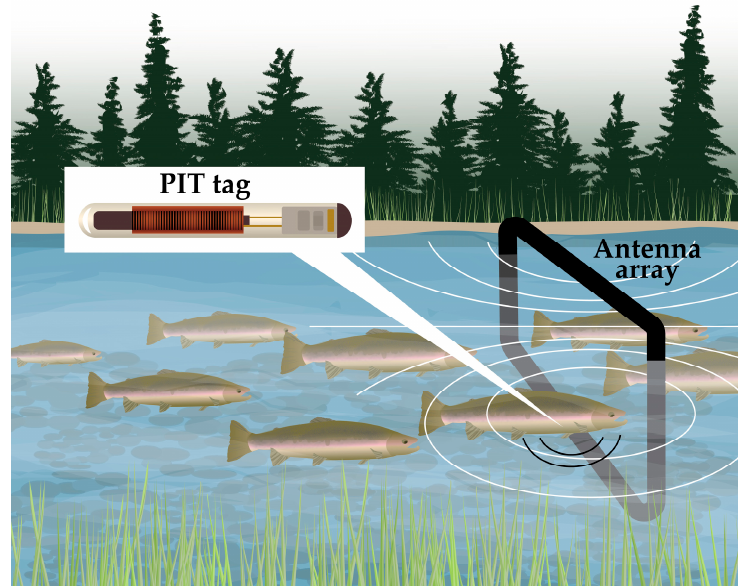
Figure 8. Example of passive integrated telemetry in fisheries management. The antenna array generates an electromagnetic field (white lines). A subcutaneous passive integrated transponder (PIT) tag inside the trout re-emits the array’s signal (black lines) as it passes through the field, providing information on PIT tag number, time, and direction of movement. Arrays may be staged at various locations along the stream reach to characterize, for example, the extent of fish passage.